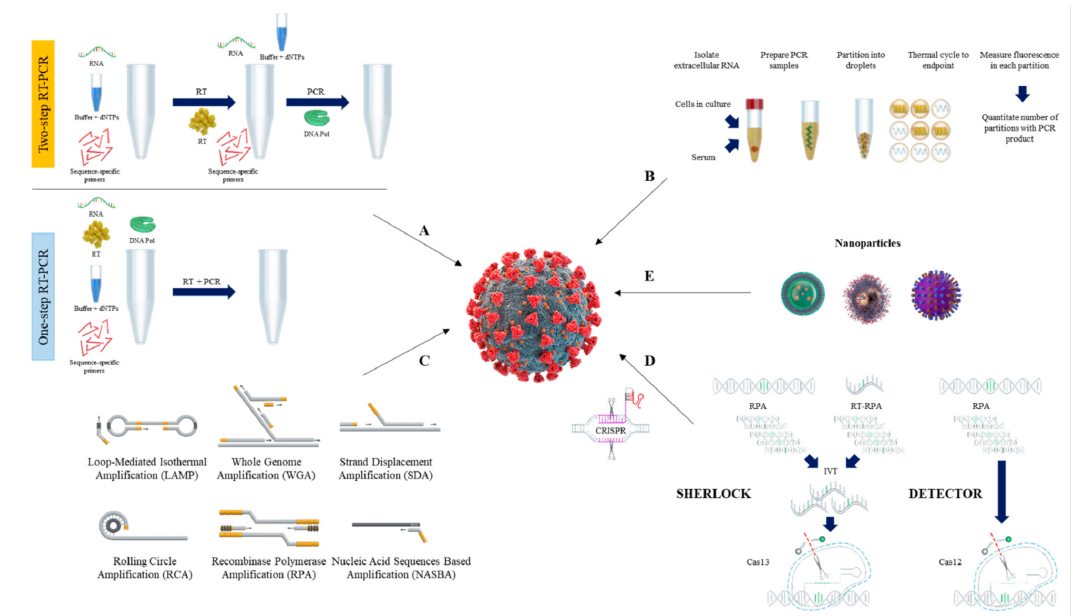
Figure 1. Overview of nucleic acid testing for SARS-CoV-2. The schematic procedure of RT-qPCR ( A ), and dPCR ( B ). Current isothermal amplification methods ( C ), CRISPR detection systems ( D ), and nanoparticles ( E ) are also